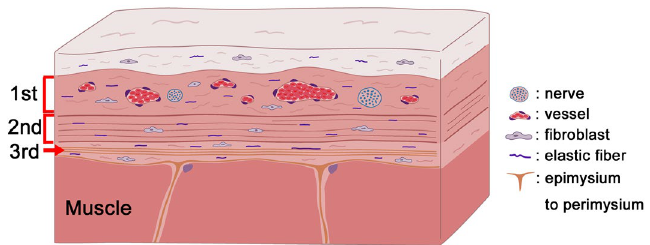
Figure 1. Schematic representation of the deep fascia, which we propose to be divided into three layers: the first superficial layer, containing collagen fibers extending in various directions with abundant vessels and nerves; the second intermediate layer, composed of single straight and thick collagen fibers with fibroblasts; and the third deepest layer, composed of straight and thin collagen fibers. A thin epimysium exists underneath the deep fascia and is connected to the perimysium. Loose connective tissue is identified between the second and third layers. Elastic fibers are found in all